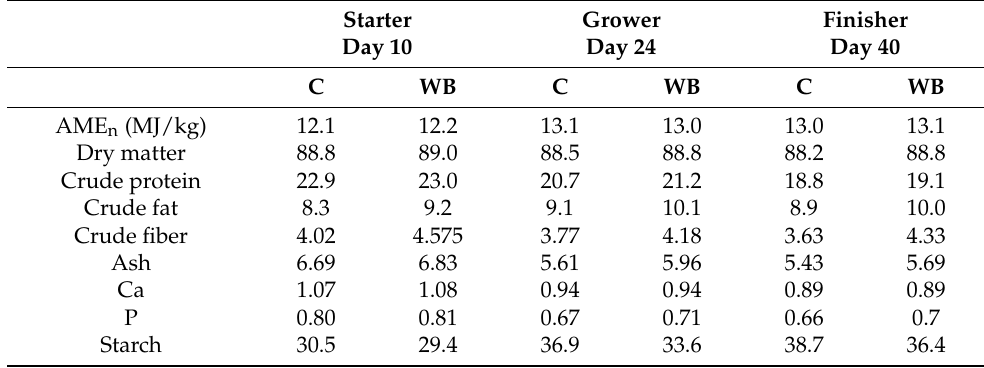
Table 2. Measured nutrient contents of the experimental diets (g/kg as